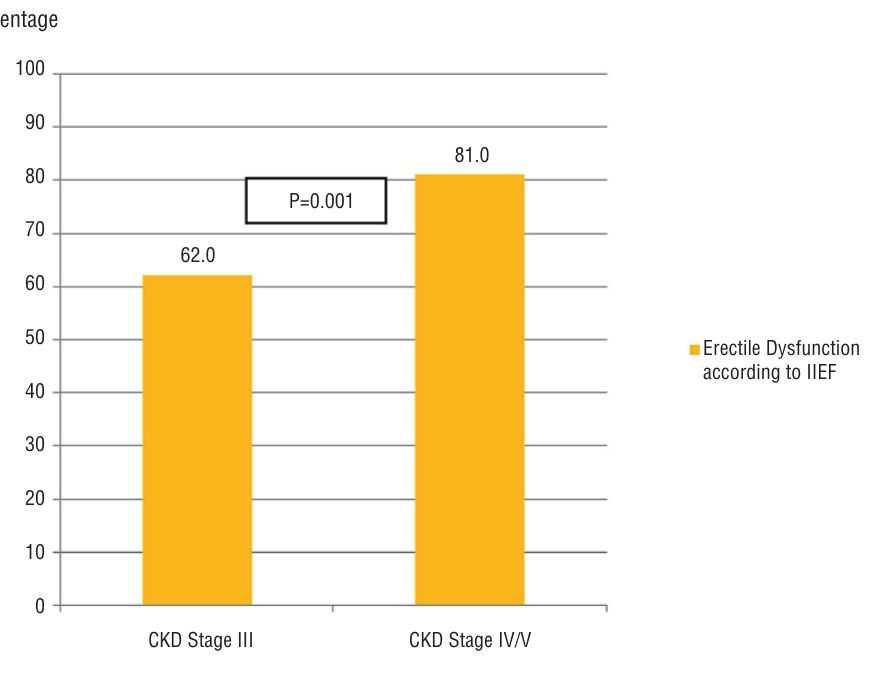
Figure 4 - Comparison of erectile dysfunction among patients with chronic kidney disease on conservative treatment in stage III versus Iv/v. Estimated by chi-square test; P=Statistical significance; CKD=Chronic Kidney Disease; IIEF=International index of erectile